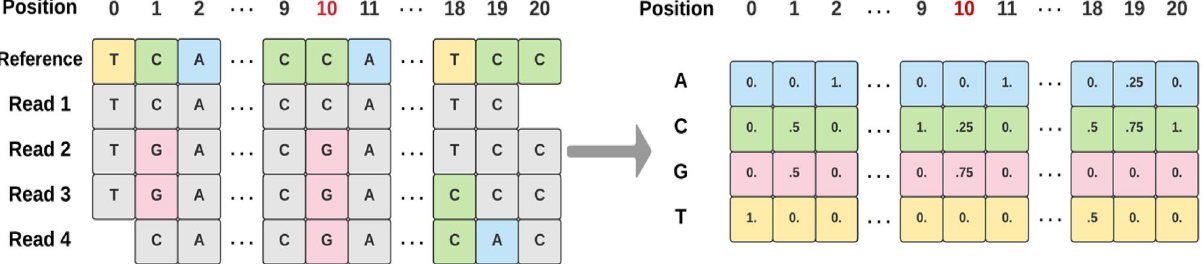
Figure 3. Conversion of raw base counts at each locus of a 21-base reference window into normalized base counts as Conv1D input of each selected SNP feature. The raw base counts were derived from reference-reads alignment, as shown on the left of this figure. The center of the window is the locus of a selected SNP feature. The normalized base counts at each locus are the percentage of the four DNA bases (ACGT),